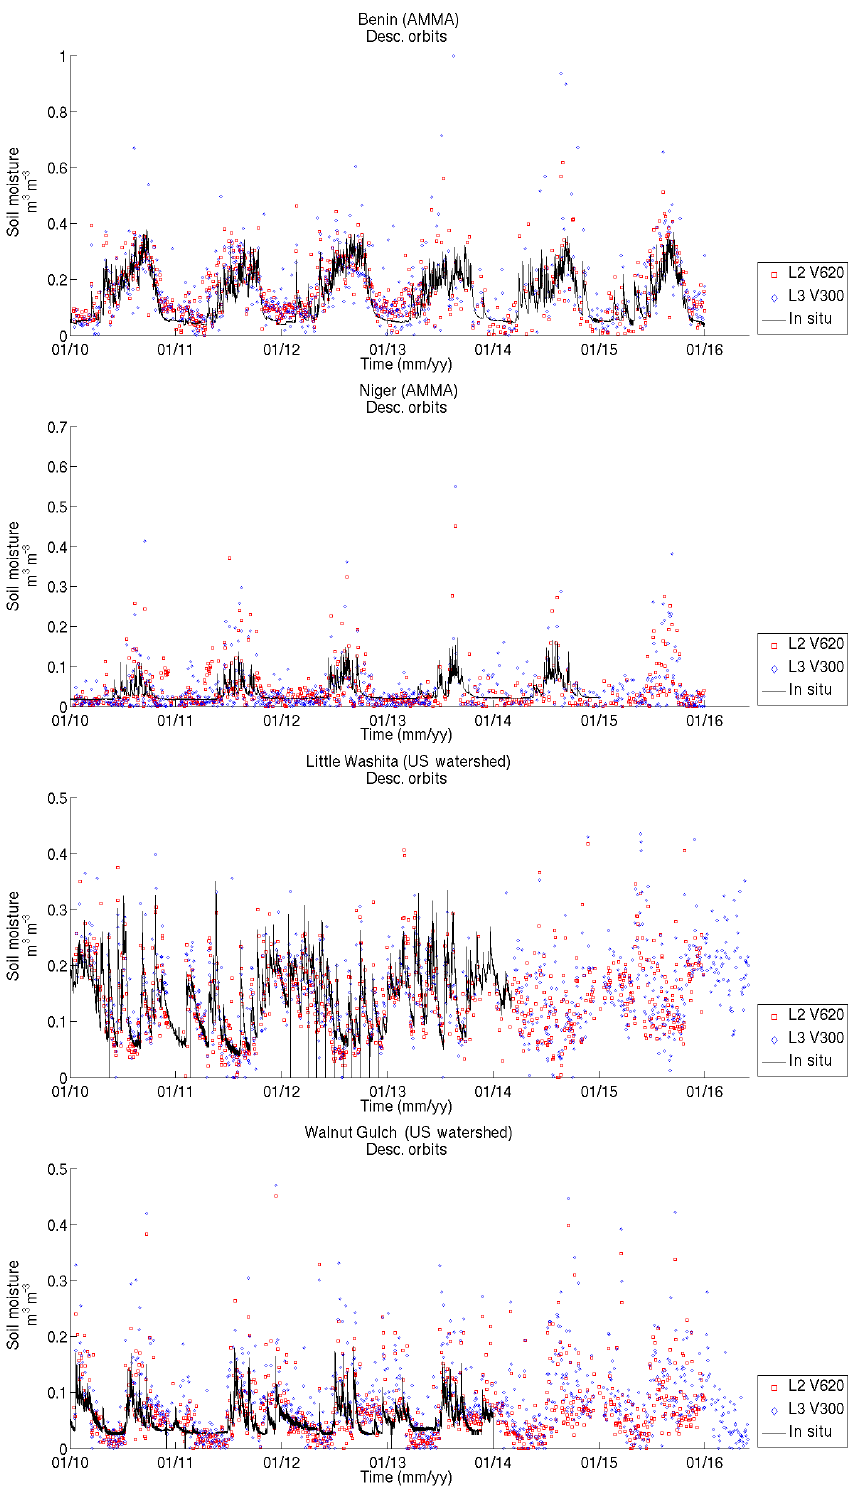
Figure 12. Time series for the validation sites for the descending (18:00UTC)